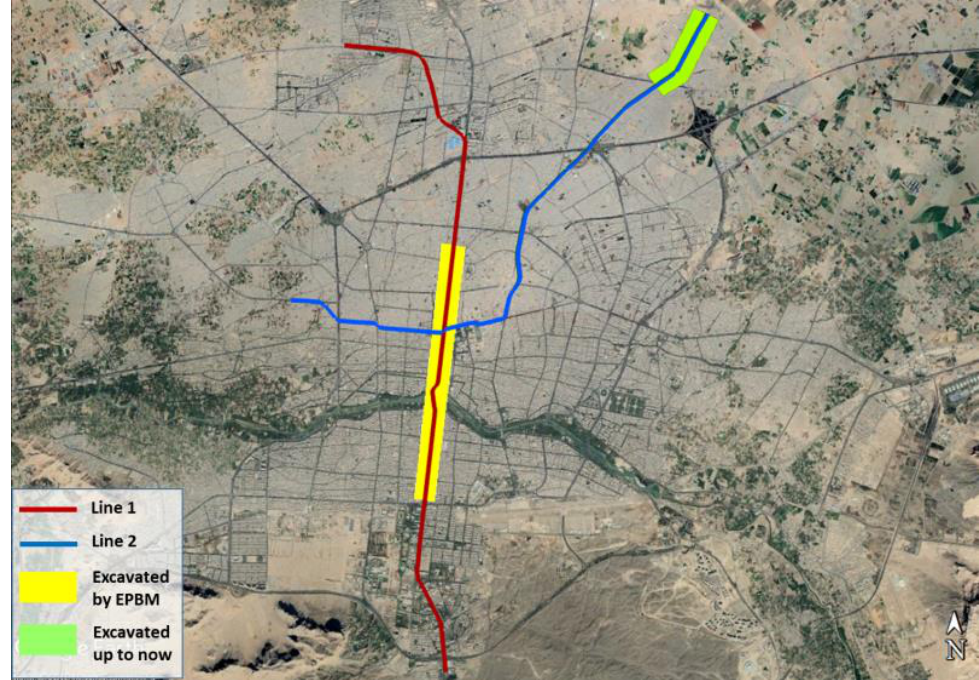
Table 1. Technical features of the EPBM used in the Isfahan metro.